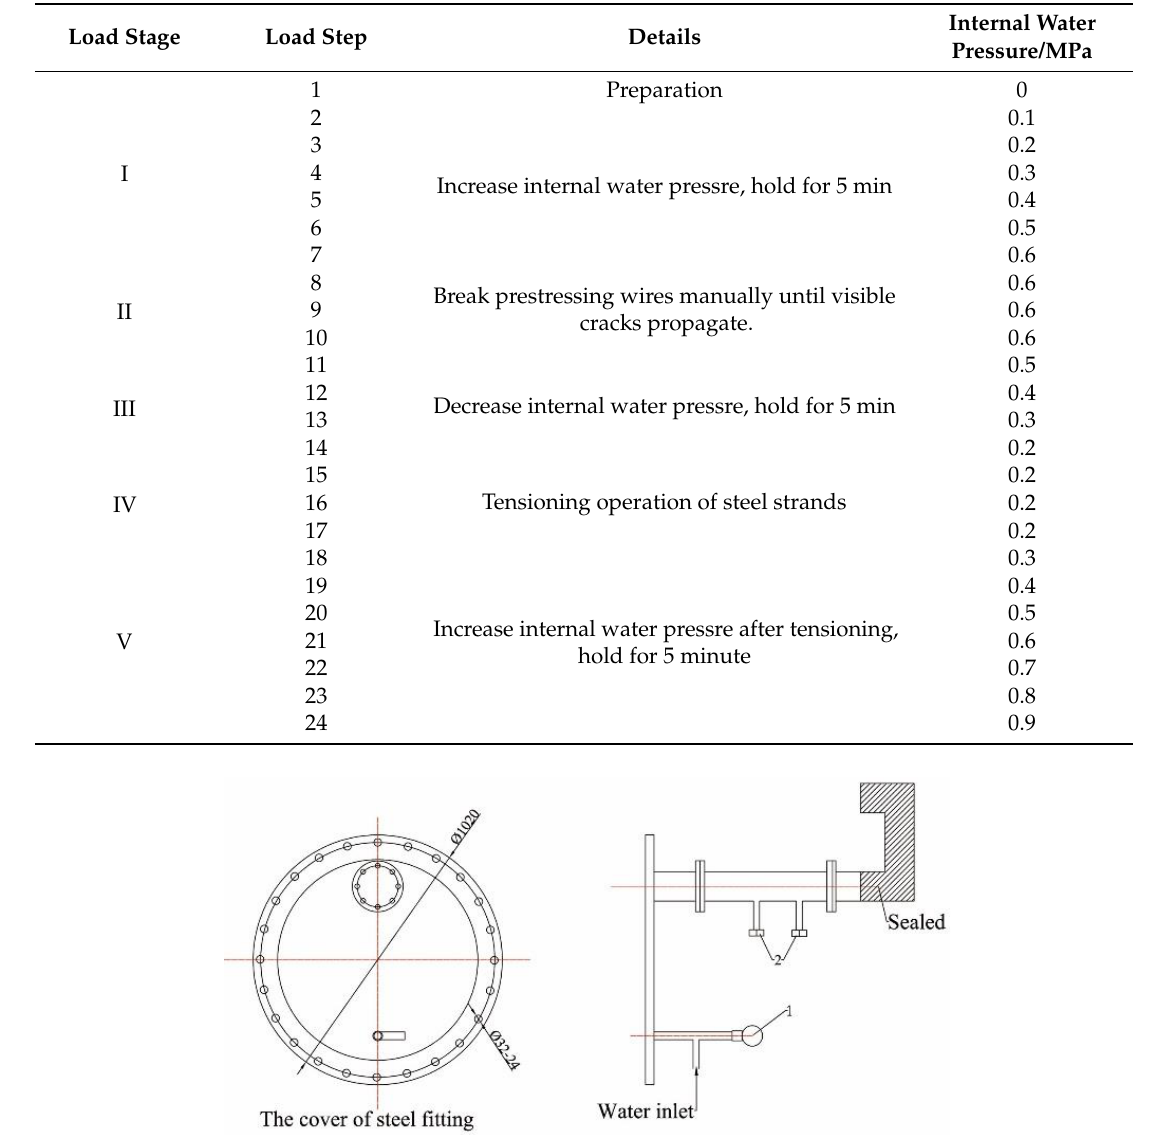
Table 3. The entire procedure and load steps.